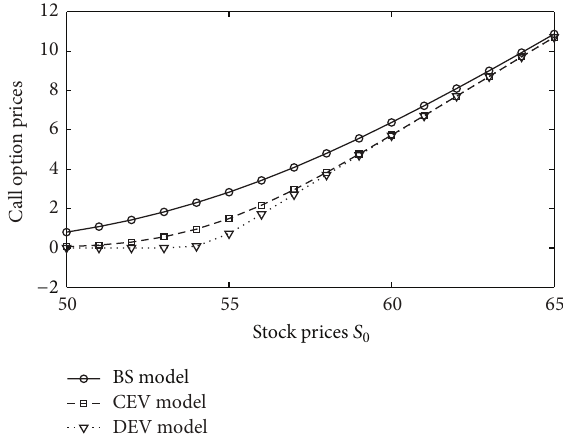
Figure 9: Call option prices at 𝐾 = 53 during “9/11” event.